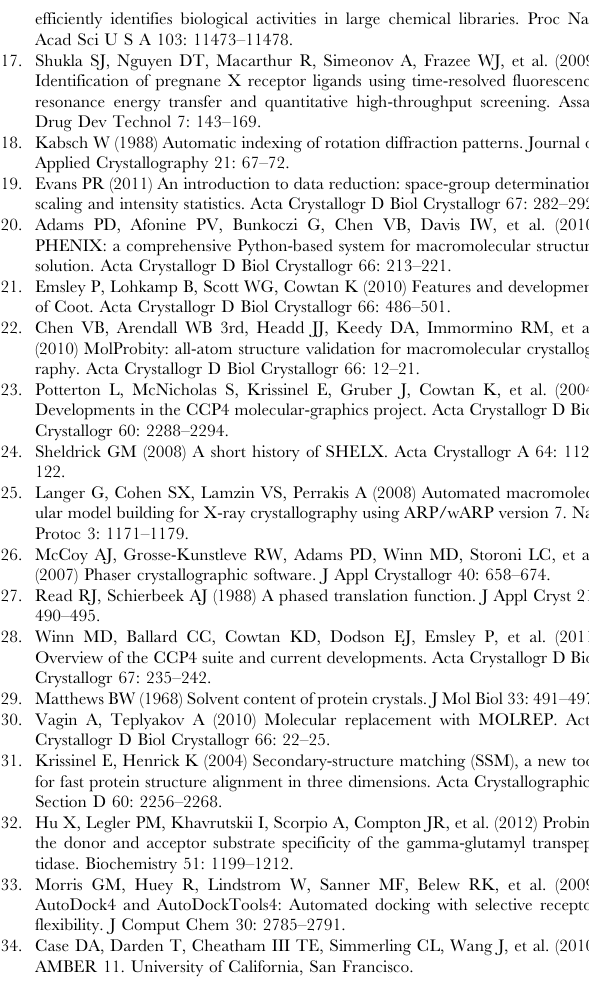
Figure S5 Plot of RMSD deviations per residue between C a atoms of ADH-WT and ADH-NADPH. Figure S6 Superposition of ADH-NADPH (green) and ADH-WT (magenta) showing the conformational chang- es observed in regions near the NADPH binding site. The NADPH molecule is drawn as cylinders. Figure S7 Hydrogen bond interactions between the active site ligands and protein for a) HADH and b) YADH. C) Active site metal binding region for HADH (blue), YADH (coral) superimposed with ADH-NADPH (green). Zn 2 + ions are drawn as spheres. Figure S8 Comparison of the Zn 2 + binding site for ADH- WT (magenta) and ADH-NADPH (green). The Zn 2 + ions